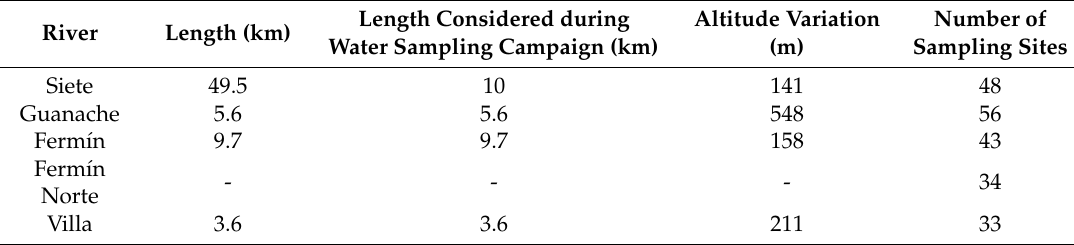
Table 1. River length, altitude variations and sampling sites.